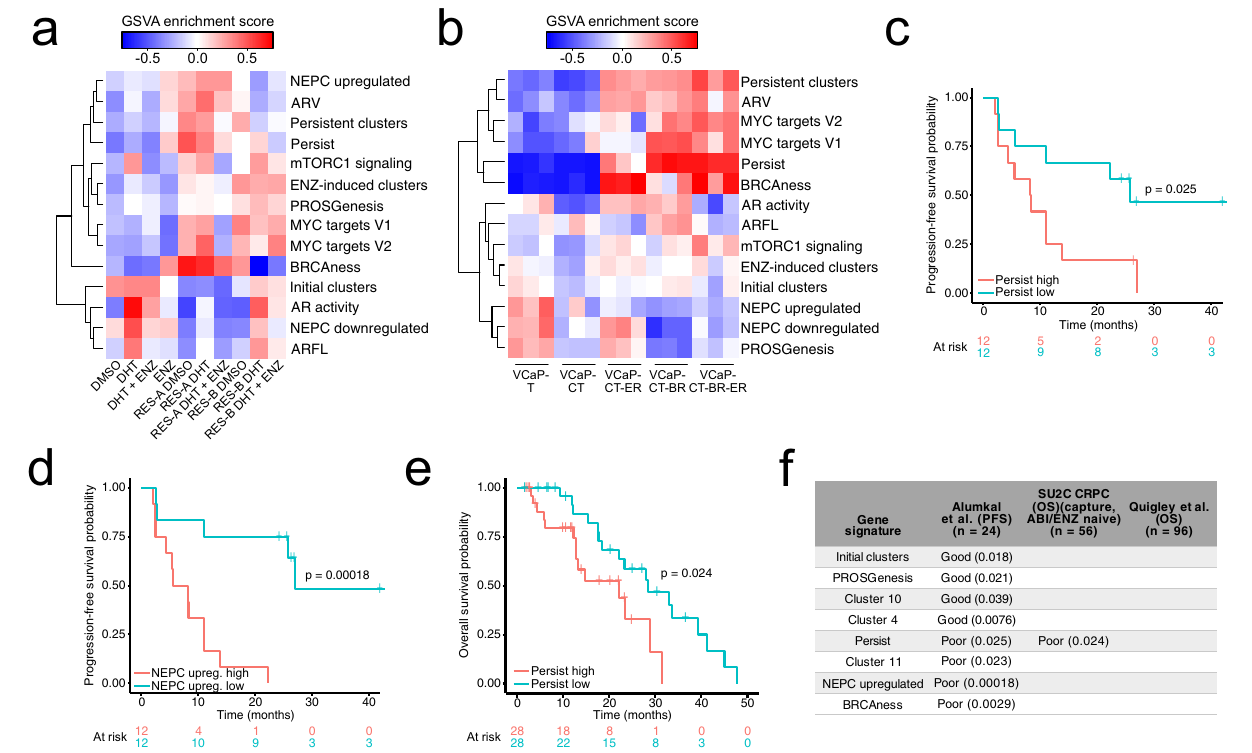
Fig. 5 Gene signatures derived from single-cell RNA sequencing capture important features of prostate cancer models and stratify patients with advanced disease. a Heatmap of single-cell gene signature gene set variation analysis (GSVA) enrichment scores in bulk RNA-sequencing of LNCaP treated with dihydrotestosterone (DHT) or enzalutamide (ENZ), and either sensitive or resistant to ENZ. b Heatmap of gene signature GSVA enrichment scores in bulk RNA sequencing from VCaP subline derivatives VCaP-T (long-term cultured with 10 µ M testosterone), VCaP-CT (VCaP-T long term cultured with 0.1 nM testosterone), VCaP-CT-ET (VCaP-CT cultured long-term with 10 µ M ENZ), VCaP-CT-BR (VCaP-CT cultured long term with bicalutamide), and VCaP-CT-BR-ER (VCaP-CT-BR long-term treated with ENZ upon reaching bicalutamide insensitivity). c Kaplan – Meier progression-free survival curves for Alumkal et al. 2 patients strati fi ed into two groups based on median GSVA score for the Persist gene signature. The two-sided log-rank p - value is shown above the curves. d Kaplan – Meier progression-free survival curves for Alumkal et al. patients strati fi ed into two groups based on median GSVA score for the NEPC-upregulated gene signature. The two-sided log-rank p -value is shown above the curves. e Kaplan – Meier overall survival curve for abiraterone (ABI)- and ENZ-naive patients from the Stand Up 2 Cancer (SU2C) CRPC cohort 5 strati fi ed into two groups based on median GSVA score for the Persist gene signature. The two-sided log-rank p -value is shown above the curve. f Summary table of gene signature GSVA score associations with progression-free survival (PFS) or overall survival (OS) in the clinical datasets. Only gene signatures signi fi cantly associated with PFS or OS in one or more datasets are shown. Good indicates that a higher score for the signature (a score higher than the median) is associated with better survival outcome, while poor indicates that a higher signature score is associated with worse survival outcome. Two-sided log-rank p -values are shown in parentheses. For each dataset, the header indicates the number of samples included, along with other qualifying information of the dataset. We used ABI/ENZ-naive patients from the capture-based SU2C CRPC RNA-seq dataset. See also Supplementary Fig.